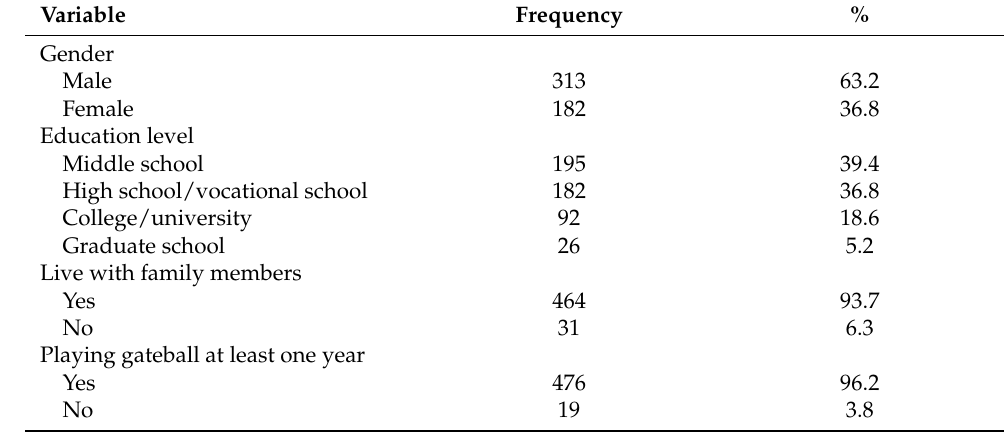
Table 1. Summary of demographic characteristics ( n = 595).